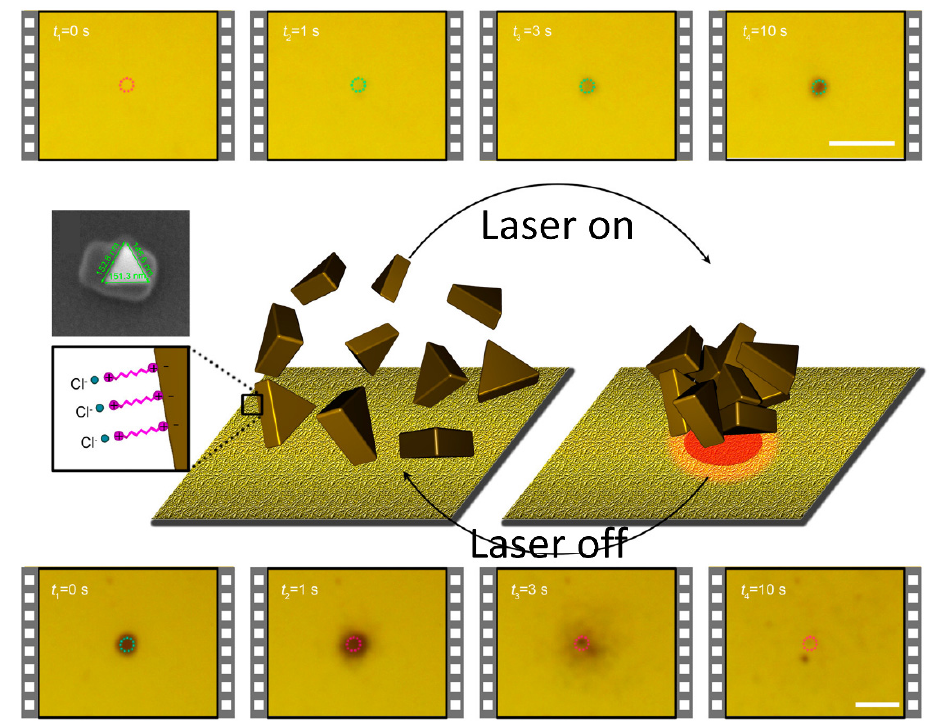
Figure 5. Reversible assembly of plasmonic nanoparticles via optical manipulation. Reprinted with permission from ref [62], Copyright 2016, American Chemical Society.